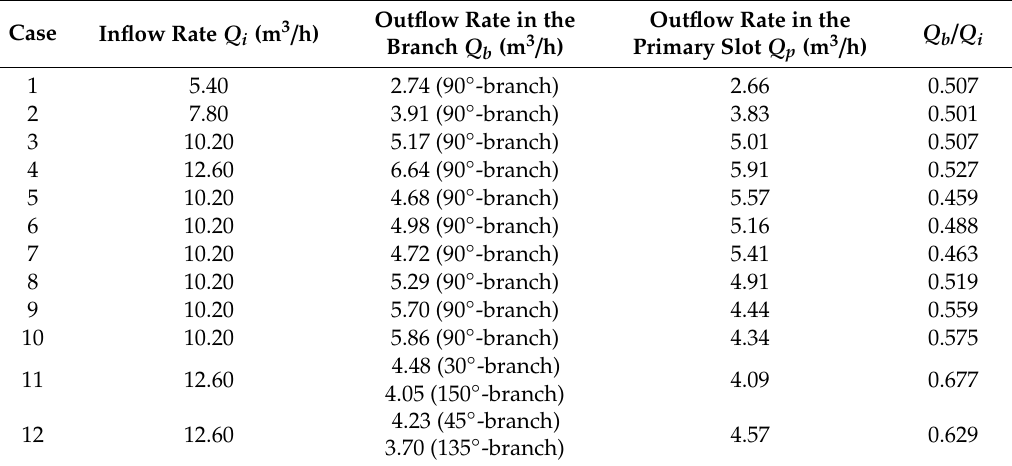
Table 3. Monitoring results of the flow rate partition at the